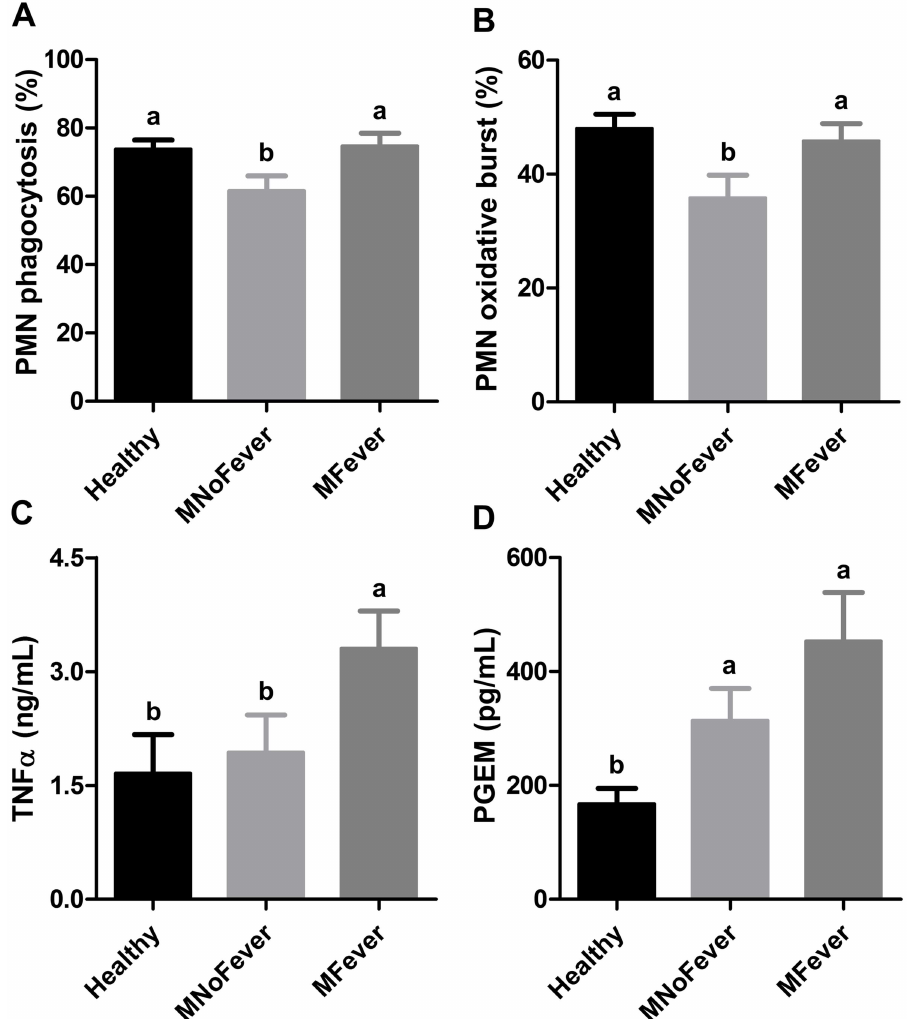
Fig 5. Immune function. (A) In vitro proportionof PMN with phagocytic activity (Healthy = 58, MNoFever = 19, MFever = 33). (B) In vitro proportion of PMN mediatedoxidative burst (Healthy = 58, MNoFever = 19, MFever = 33). (C) In vivo serum TNF α (14 cows per group). (D) In vivo serum PGE 2 metabolite (14 cows per group). Data represent the mean ± SEM. Data labeled“a” are statistically different ( P (cid:20) 0.05) from data labeled“b”. See S1 Table for sample